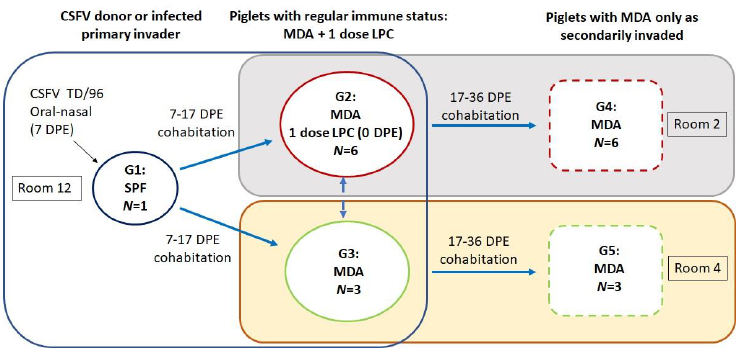
Figure 1. Experimental design.